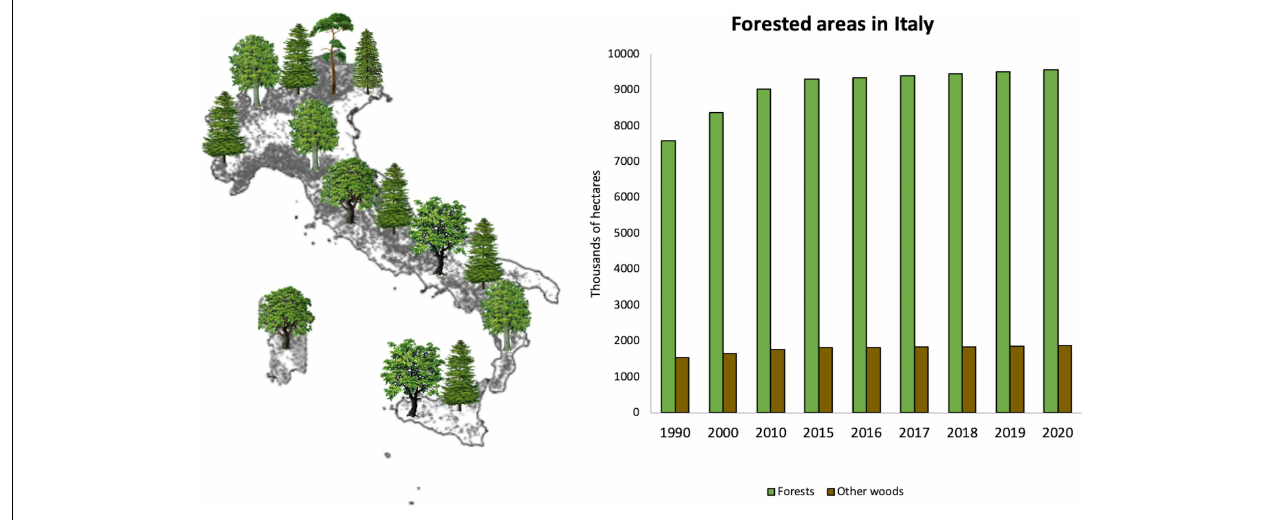
FIGURE 1 | Forested areas in Italy (data from: “National Inventory of Forests and Forest Carbon Pools-INFC”,